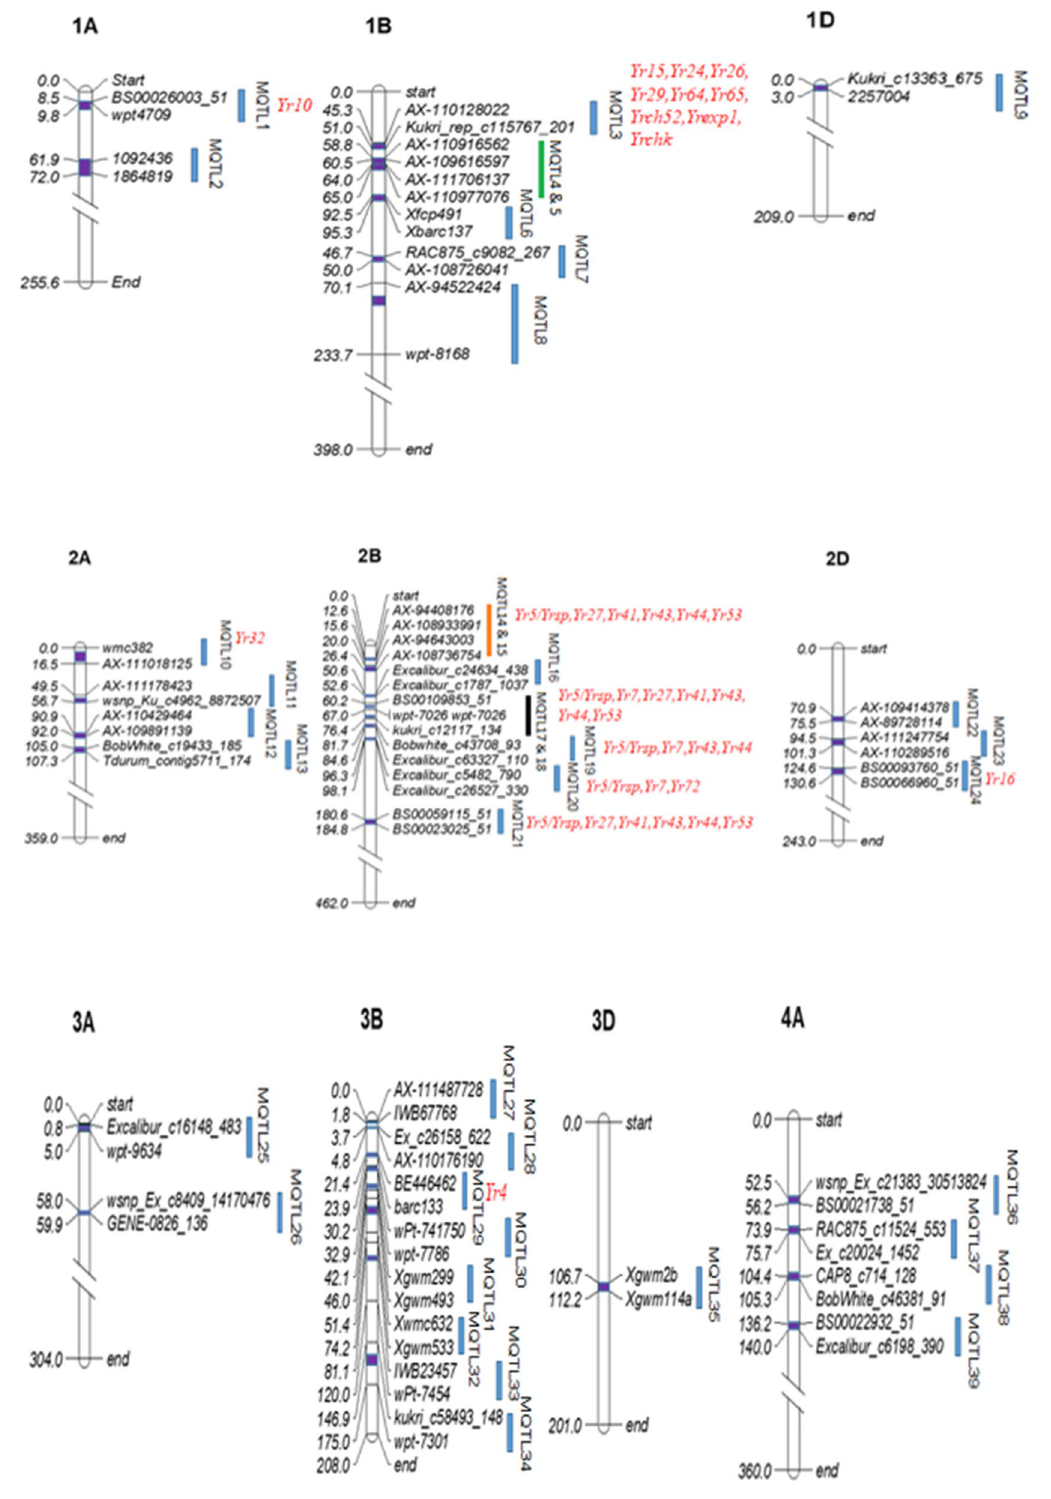
Figure 3. Distribution of 61 MQTLs on 18 chromosomes of wheat. The dark blue rectangular blocks inside each chromosome indicate MQTL regions and the light blue vertical bars on the right of each chromosomes indicate marker intervals. Marker intervals, occupying closely linked pairs of QTL are shown by the green, orange, black and pink colors. Only the flanking markers most closely associated with MQTLs have been shown in the figure. The Yr genes located in the marker interval of the MQTLs are indicated in red